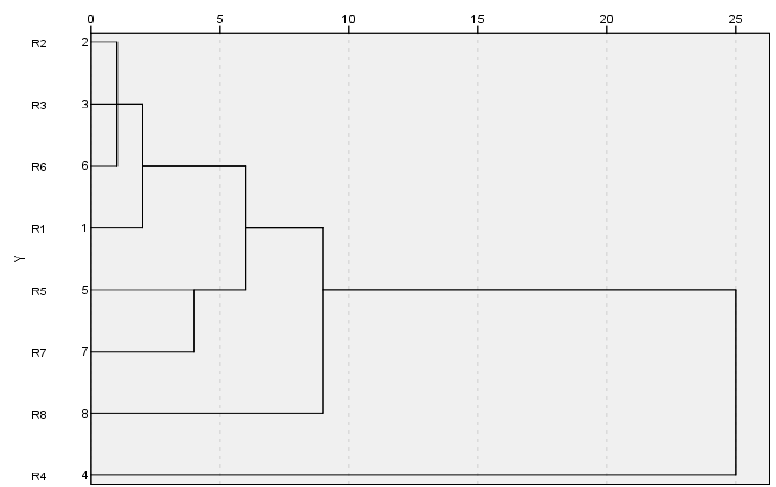
Figure 1. Dendrogram of the distance between the eight accessions of Rosmarinus officinalis L., using hierarchical clustering method. Table 3. Grouping of eight Rosmarinus o ffi cinalis L. accessions into chemotypes based on the major component of essential